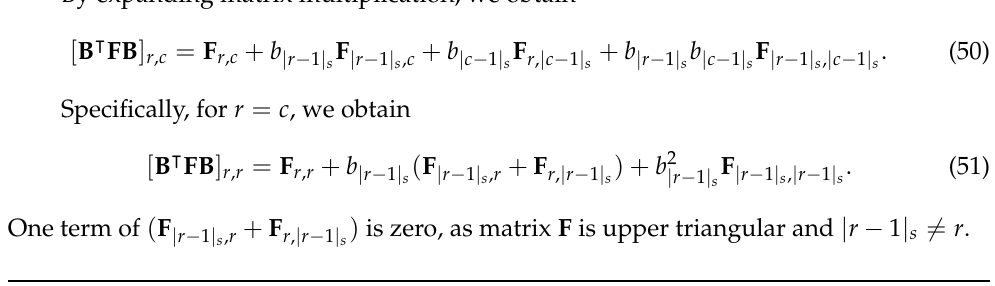
(cid:17) ( u ) ] r , c u , u B